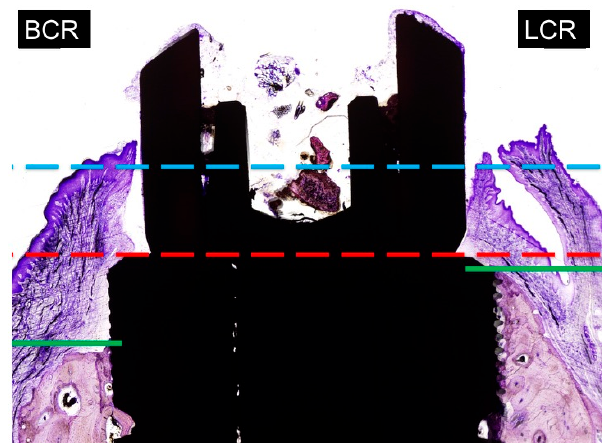
Figure 7. Measurements of marginal bone loss: BCR: buccal crest resorption (distance from the top of the implant shoulder to the first BIC in the buccal crest side. LCR: lingual crest resorption (distance from the top of the implant shoulder to the first BIC in the lingual crest side).